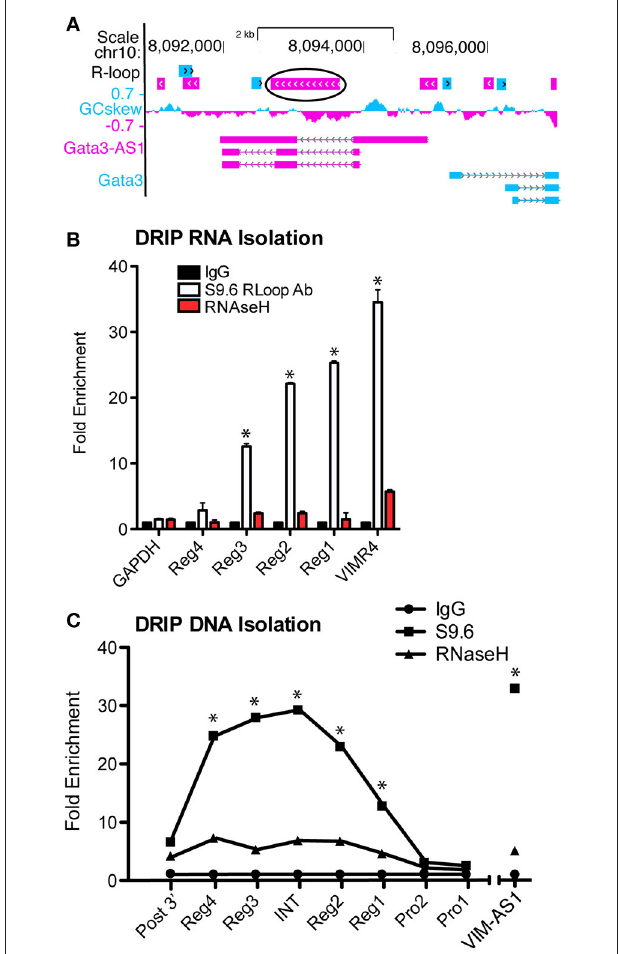
FIGURE 5 | GATA3-AS1 RNA forms an R-Loop with the central intron of GATA3-AS1 . (A) Predictive R-Loop formations according to the R-Loop database. The largest and most likely R-Loop is circled, located between regions 2 and 3 of GATA3-AS1 . (B) DRIP assay completed with RNA isolation. Results are expressed as fold enrichment relative to the RNase H negative control. Chromatin was treated with RNase to remove R-Loops as an additional control, mean ± S.D. ( n = 3). * P < 0.05. (C) DRIP assay similar to (B) , but DNA was isolated from the R-Loop immunoprecipitates. PRO1 and 2 represent the shared promoter region, INT is the central intron of GATA3-AS1, and Post3’ is past the GATA3-AS1 transcriptional end site. Statistical evaluations were performed using Students t -test vs. Rnase H negative control. All data represent mean ± S.D. as fraction of input ( n = 4). * P <